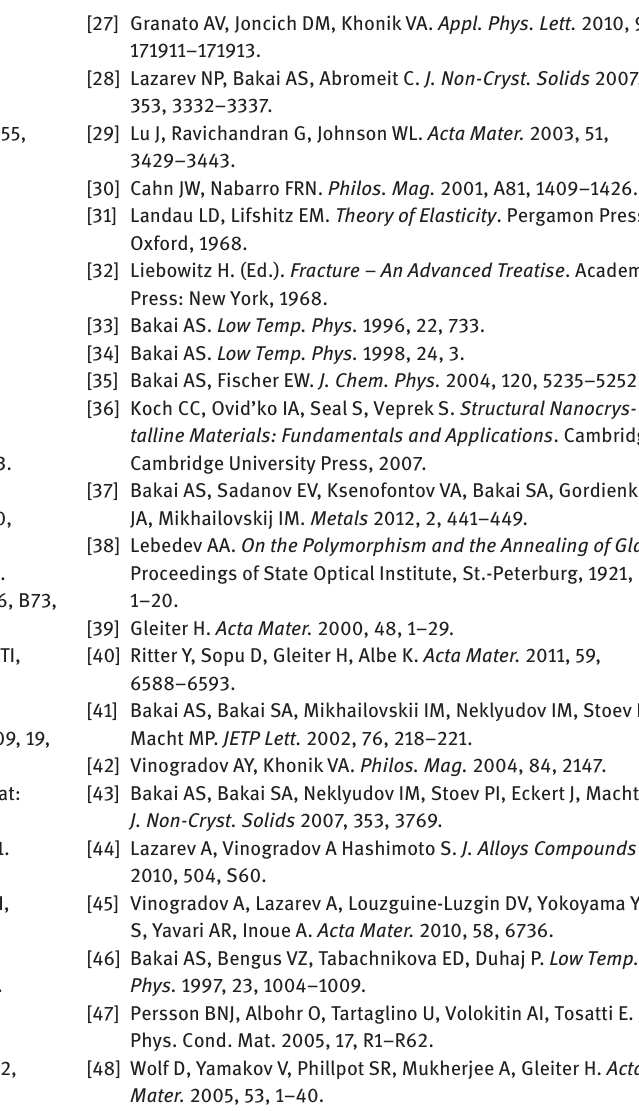
the atomic configuration goes from a site to a neighbor- ing site without thermal activation. The parameter σ critical shear stress at site i